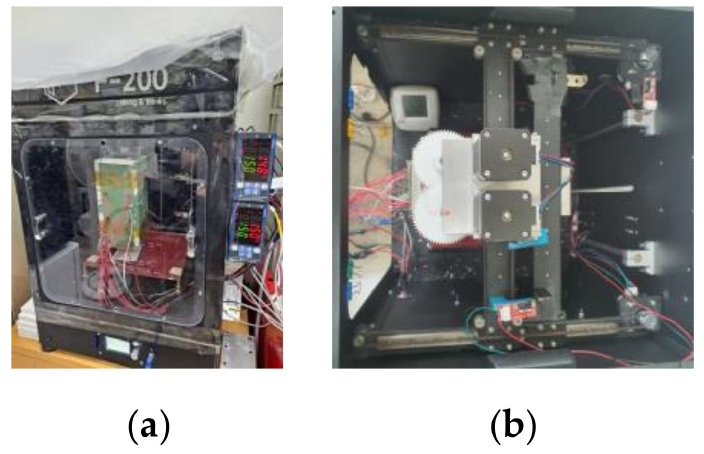
Figure 2. Candy 3D printer: ( a ) front view, ( b ) top